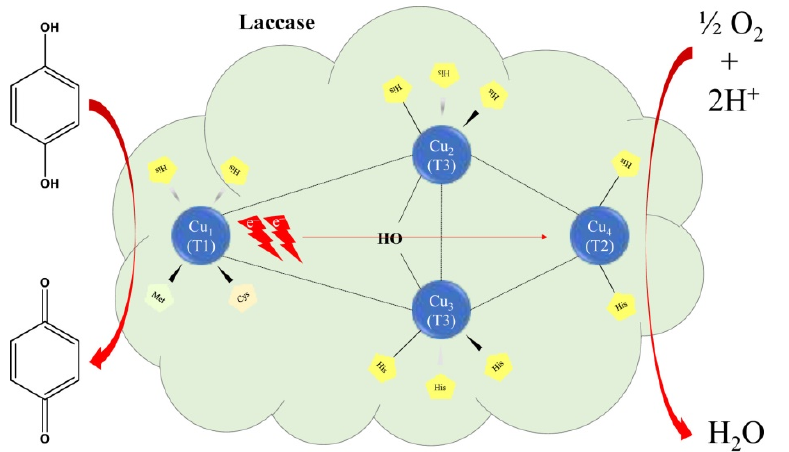
Figure 7. Schematic representation mechanism of substrate oxidation by Lac. Reprinted from [34,137] with permission of publisher. with permission of